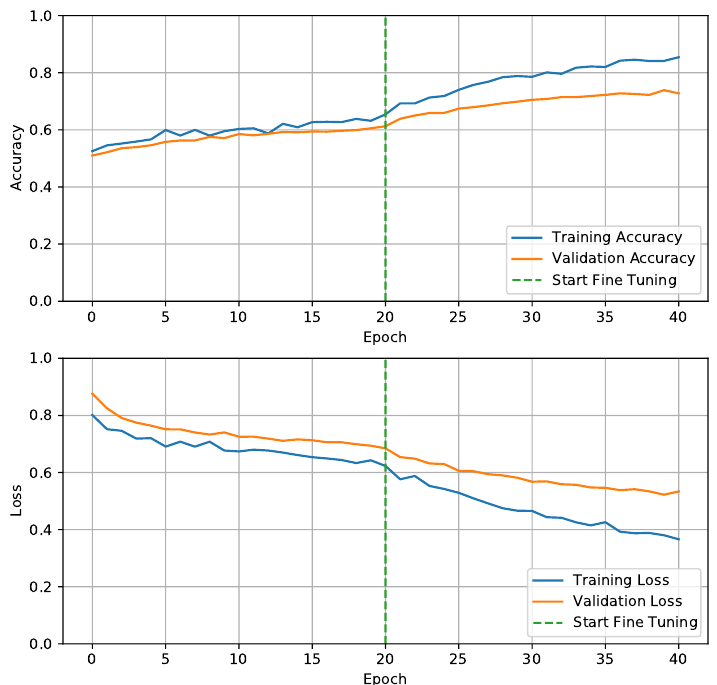
Figure 5. Training Feature Extraction (FE) based on MobileNetV2 model. On the first 20 epochs, only output neurons are trained. Afterwards, the entire model is fine tuned.